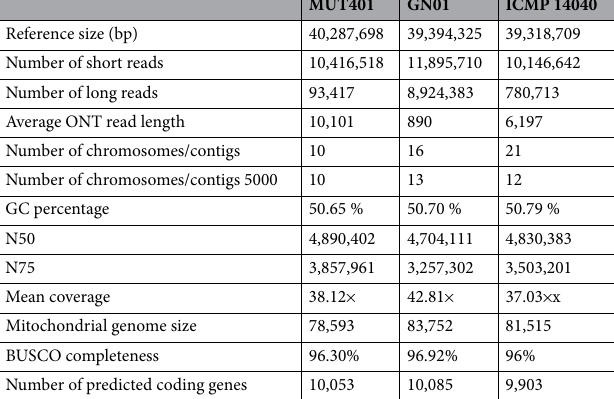
Table 1. Assembly statistics and annotation